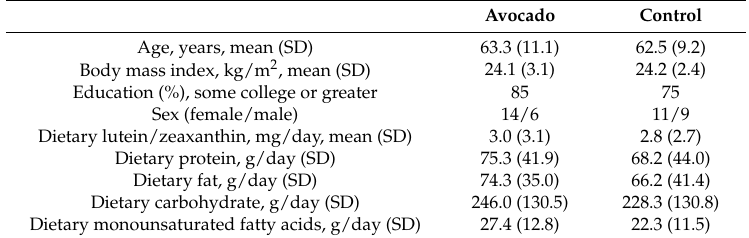
Table 2. The baseline characteristics of healthy subjects consuming one medium avocado a